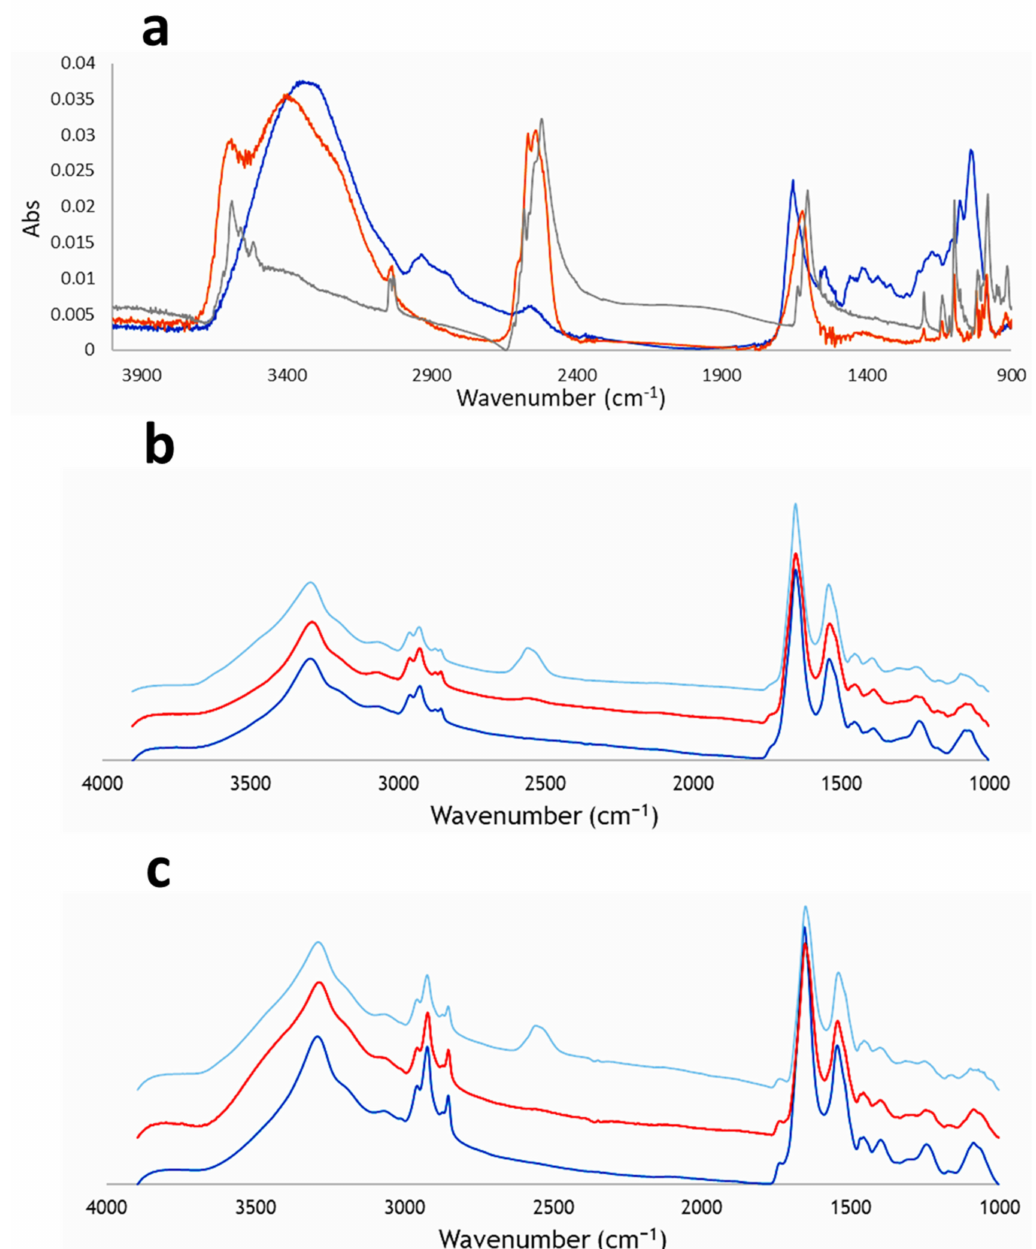
Figure 5. GICs Na[ o -COSAN] − uptake analyses by SR-FTIRM. Na[ o -COSAN] spectra display a strong and characteristic ν (B-H) frequency at the infrared range 2.600–2.500 cm − 1 in which no other frequencies of organic compounds appear. The IR spectrum of Na[ o -COSAN] in solid-state displays the ν (B-H) and ν (C c -H) frequencies at 2582–2522 and at 3031 cm − 1 , respectively. ( a ) IR spectra of Na[ o -COSAN] recorded in solid-state (grey), 2 mM of Na[ o -COSAN] in aqueous solution (orange) and 2 mM of Na[ o -COSAN] in culture media solution (blue). ( b ) IR spectra of GIC7 cells: control cells (dark blue), cells incubated with 200 µ M of Na[ o -COSAN] for 5 h (red) and, cells incubated with 2 mM of Na[ o -COSAN] for 5 h (light blue). ( c ) IR spectra of PB88 cells: control cells (dark blue), cells incubated with 200 µ M of Na[ o -COSAN] for 5 h (red) and, cells incubated with 2 mM of Na[ o -COSAN] for 5 h (light